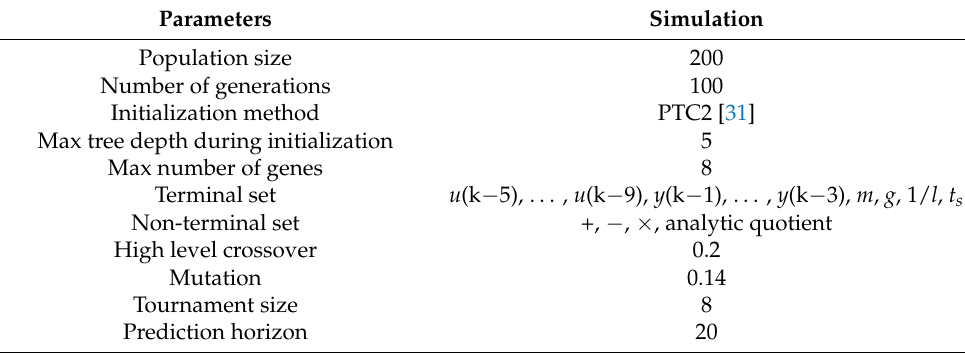
Figure 12. Excitation input signal (control input), position response and sway response for training data set with rope length of 1.2 m and payload mass of 20 kg. Table 6. Multi-gene genetic programming parameters for experimental data.